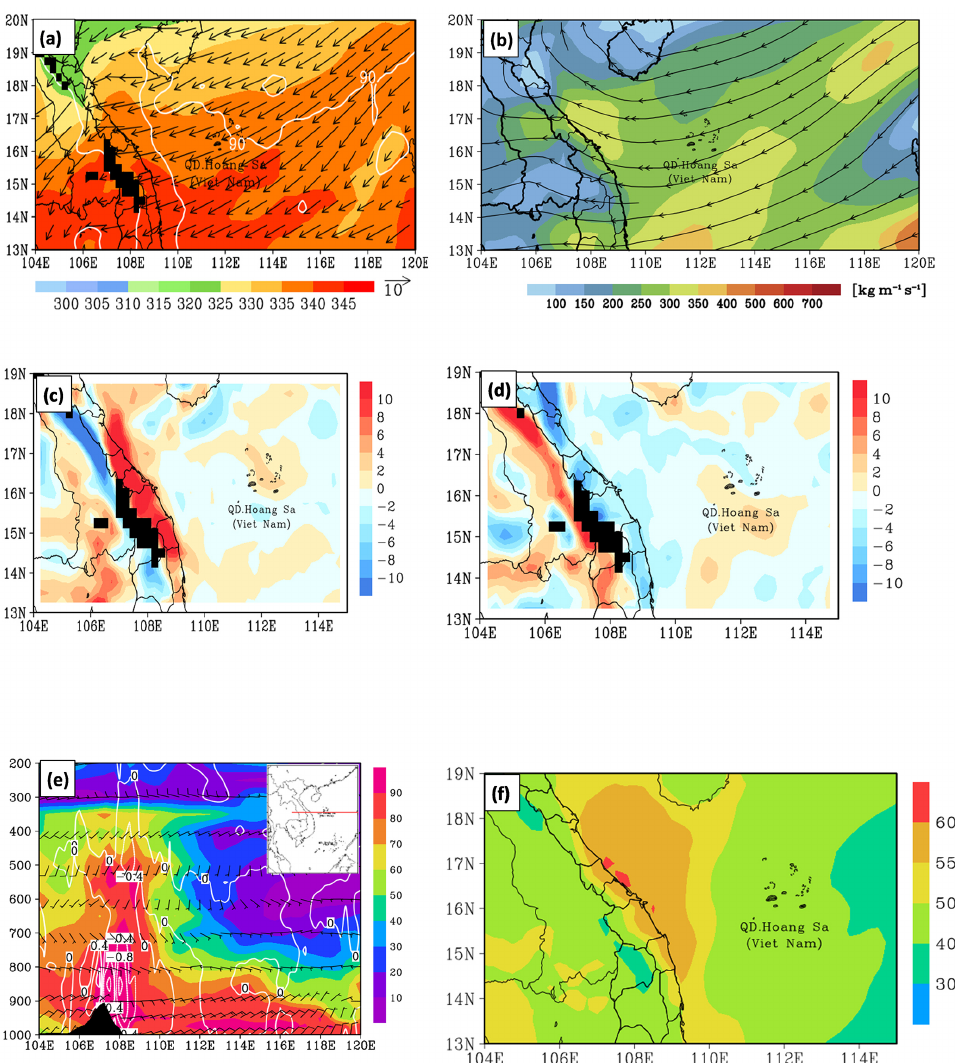
Figure 11. As in Fig. 9, except for 12:00UTC on 10 December